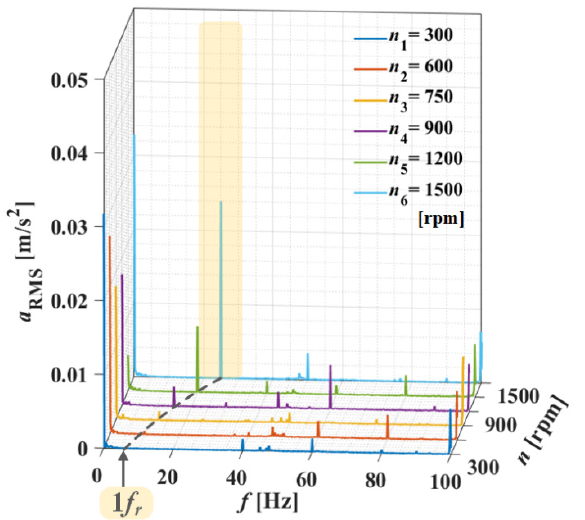
Figure 7. Spectra of mechanical vibration acceleration as a function of rotational speed change, n , for unbalance mass, m 5 .